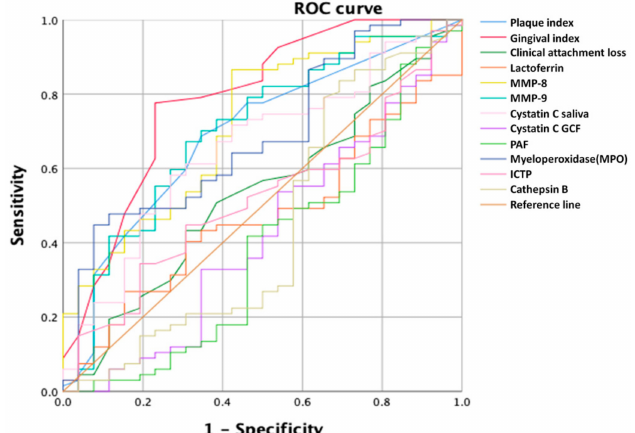
Figure 2. Receiver operating characteristic (ROC) curve of clinical parameters and biomarkers. Only plaque index, gingival index, MMP-8, MMP-9, MPO, and cystatin C showed convex shape of curve. Concave curve means subject of ROC curve does not have any diagnostic ability. As the diagnostic power of subject is increased, convexity of ROC curve increases. MPO, myeloperoxidase; MMP-8, matrix metalloproteinase-8; MMP-9, matrix metalloproteinase-9; GCF, gingival crevicular fluid; PAF, platelet activating factor; ICTP, pyridinoline cross-linked carboxyterminal telopeptide of type I collagen.